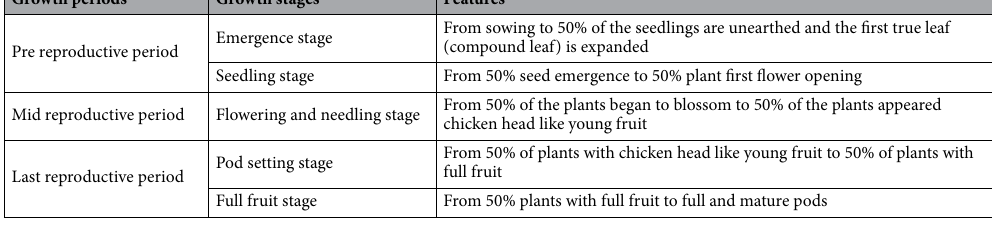
Table 1. Division of peanut growth